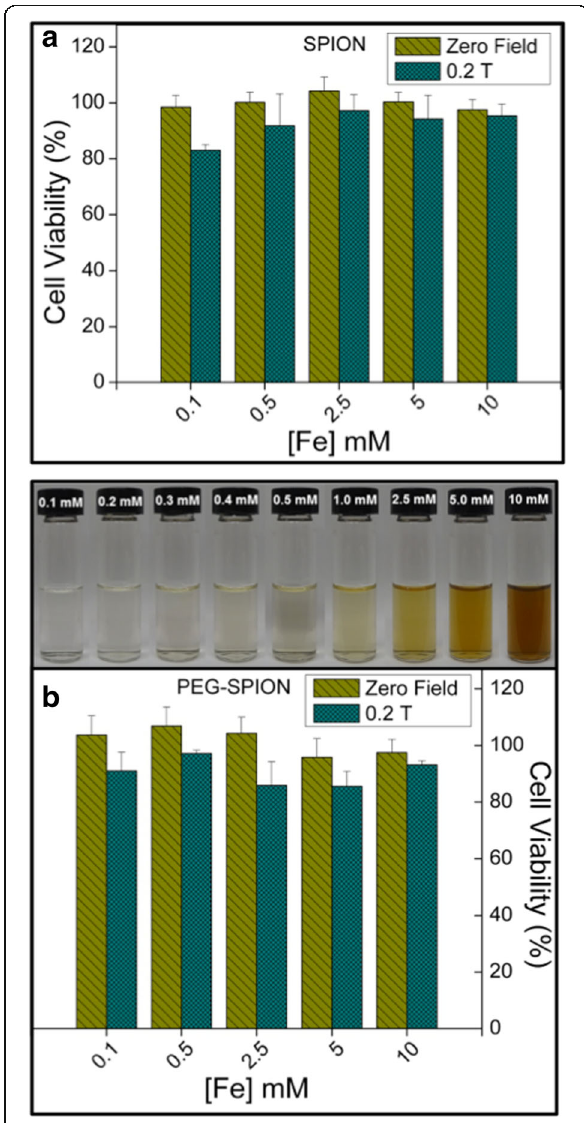
Fig. 7 In vitro MTS cytotoxicity assays showing the HeLa cell viability in the presence of SPION ( a ) and PEG-SPION ( b ) at different concentrations after incubation for 24 h, and in absence and presence of an external static magnetic field. The upper inset in b shows the optical images of PEG-SPION in solution at different